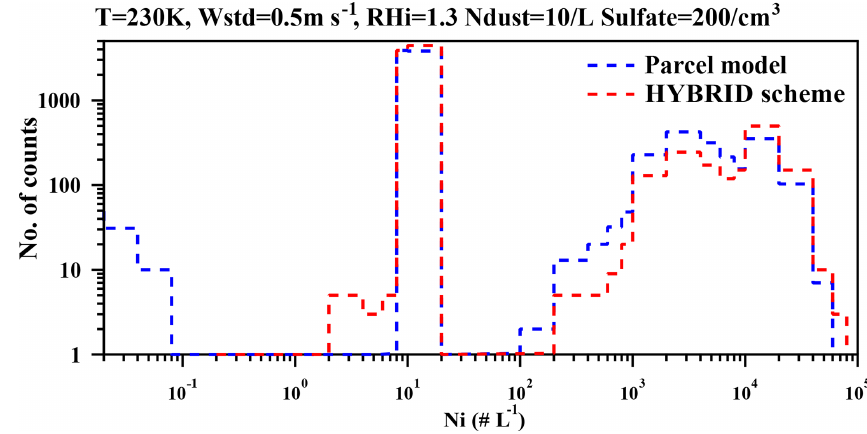
Figure 1. Histogram of predicted ice number concentration for 10000 simulations using an adiabatic parcel model (blue dashed line) and a box model using the HYBRID scheme (red dashed line). Wstd is the standard deviation of the assumed pdf of updraft velocities, while Ndust and Sulfate are the assumed dust and sulfate number